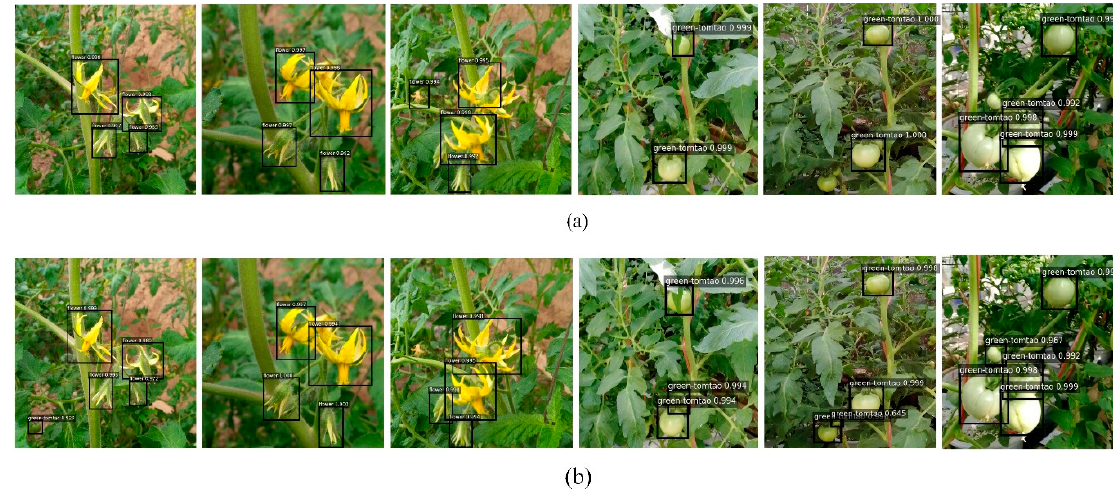
Figure 6. Visualization results using different pooling types. ( a ) Testing results of model 2 using average-pooling; ( b ) Testing results of model 4 using max-pooling.